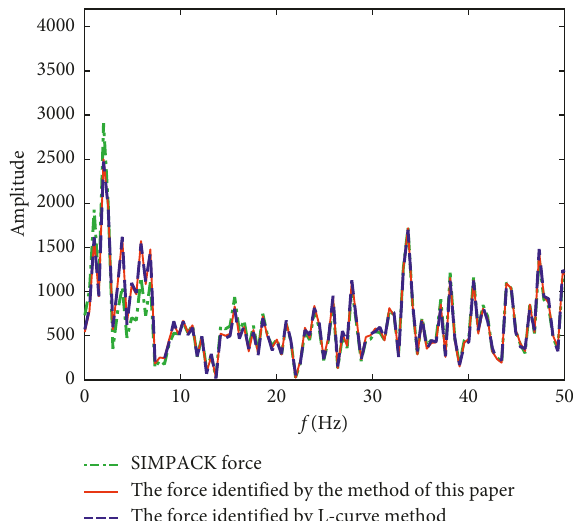
Figure 30: Load time-history diagram of the two methods for F identification when the noise level is 0%.